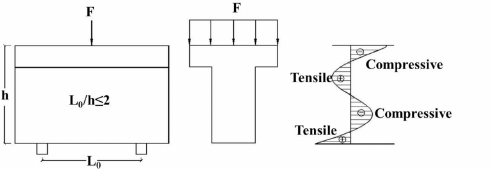
Figure 1. Strain distribution on mid-span section of deep T-cross section beam. Note: F: Load, h: the height of T beam, L 0 : clear span of T